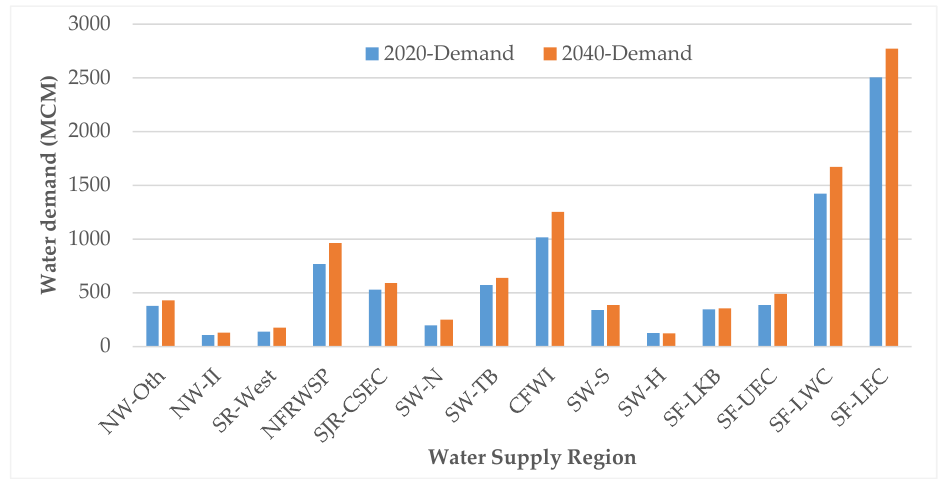
Figure 4. Total Annual Demand Projections and Potential Water Needed by Water Supply Planning Regions. Note: Two regions, SR-West and NFRWSP have water projections to 2035 only. Linear extrapolations of water use are applied to project water demands to 2040. Source: development water